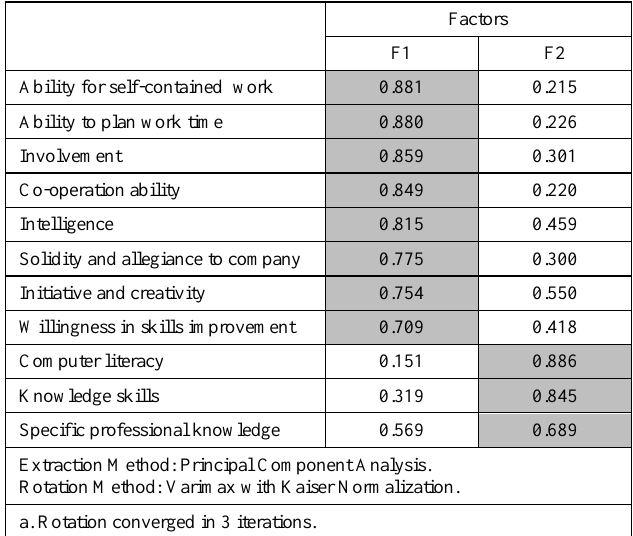
Extraction Method: Principal Component Analysis. Rotation Method: Varimax with Kaiser Normalization. a. Rotation converged in 3